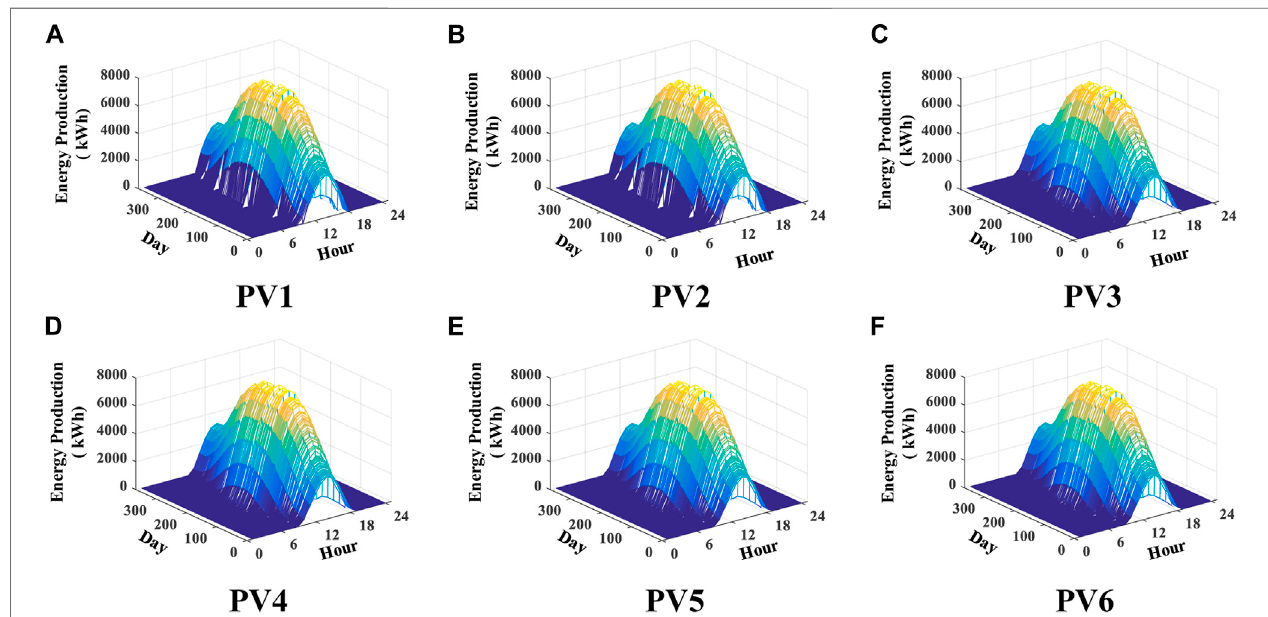
FIGURE 9 | Energy production for each hour during a year of the six con fi gurations. (A) PV1. (B) PV2. (C) PV3. (D) PV4. (E) PV5. (F) PV6.